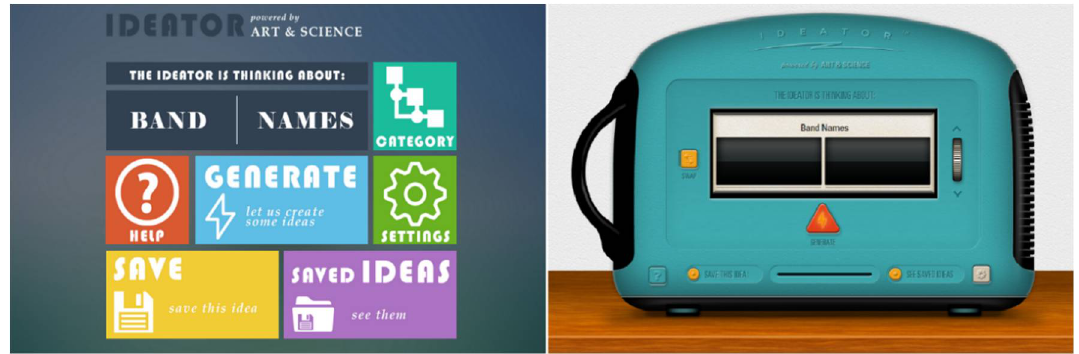
Figure 10. Flat and skeuomorphic variations of the Ideator website.